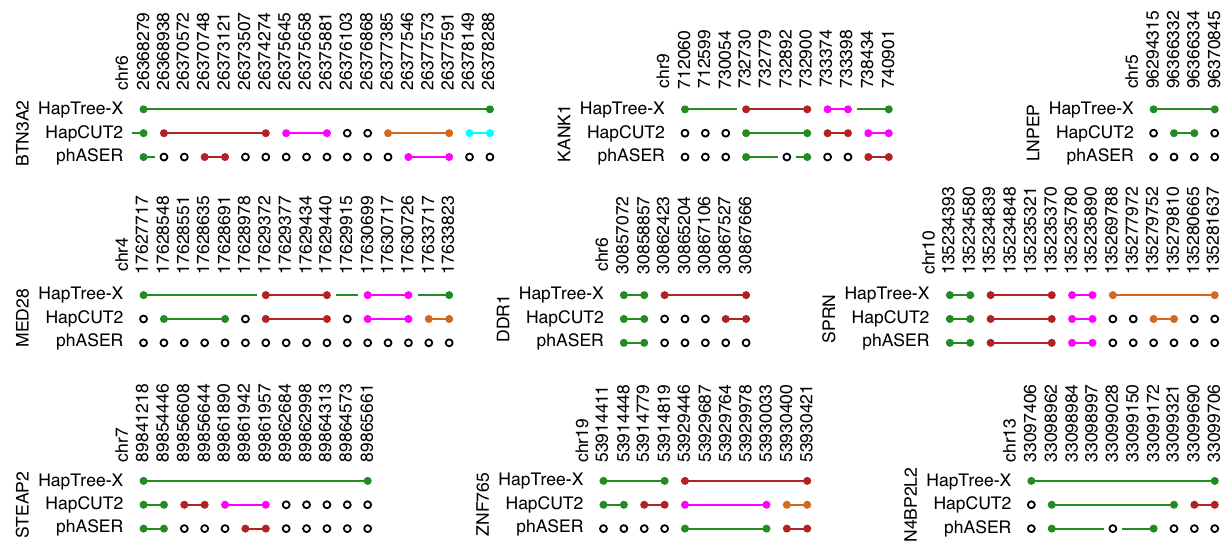
Fig. 2 Phasing of nine disease-associated genes by HapTree-X, HapCUT2, and phASER using whole-cell RNA-seq data from GM12878. Unphased SNPs are represented by an empty circle, and each phased block is given a unique color. Note that some blocks might overlap because not all SNPs from a gene exhibit DASE. Reported SNP loci are relative to the human genome hg19 (GRCh37).